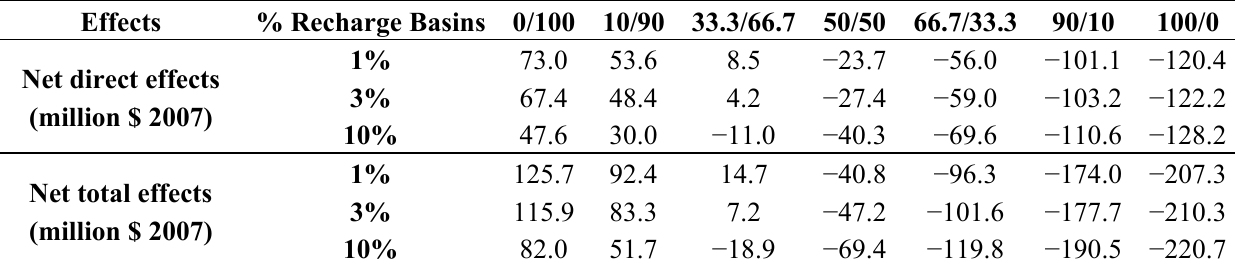
Table 7. Direct and total changes in sector output for Table 6 scenarios in a 1000 m land use buffer.